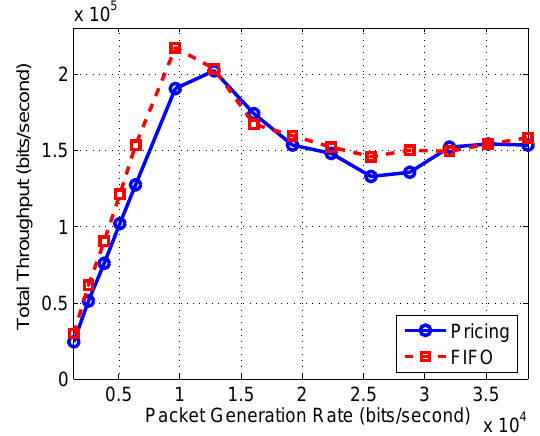
Figure 17. Aggregate system throughput for random